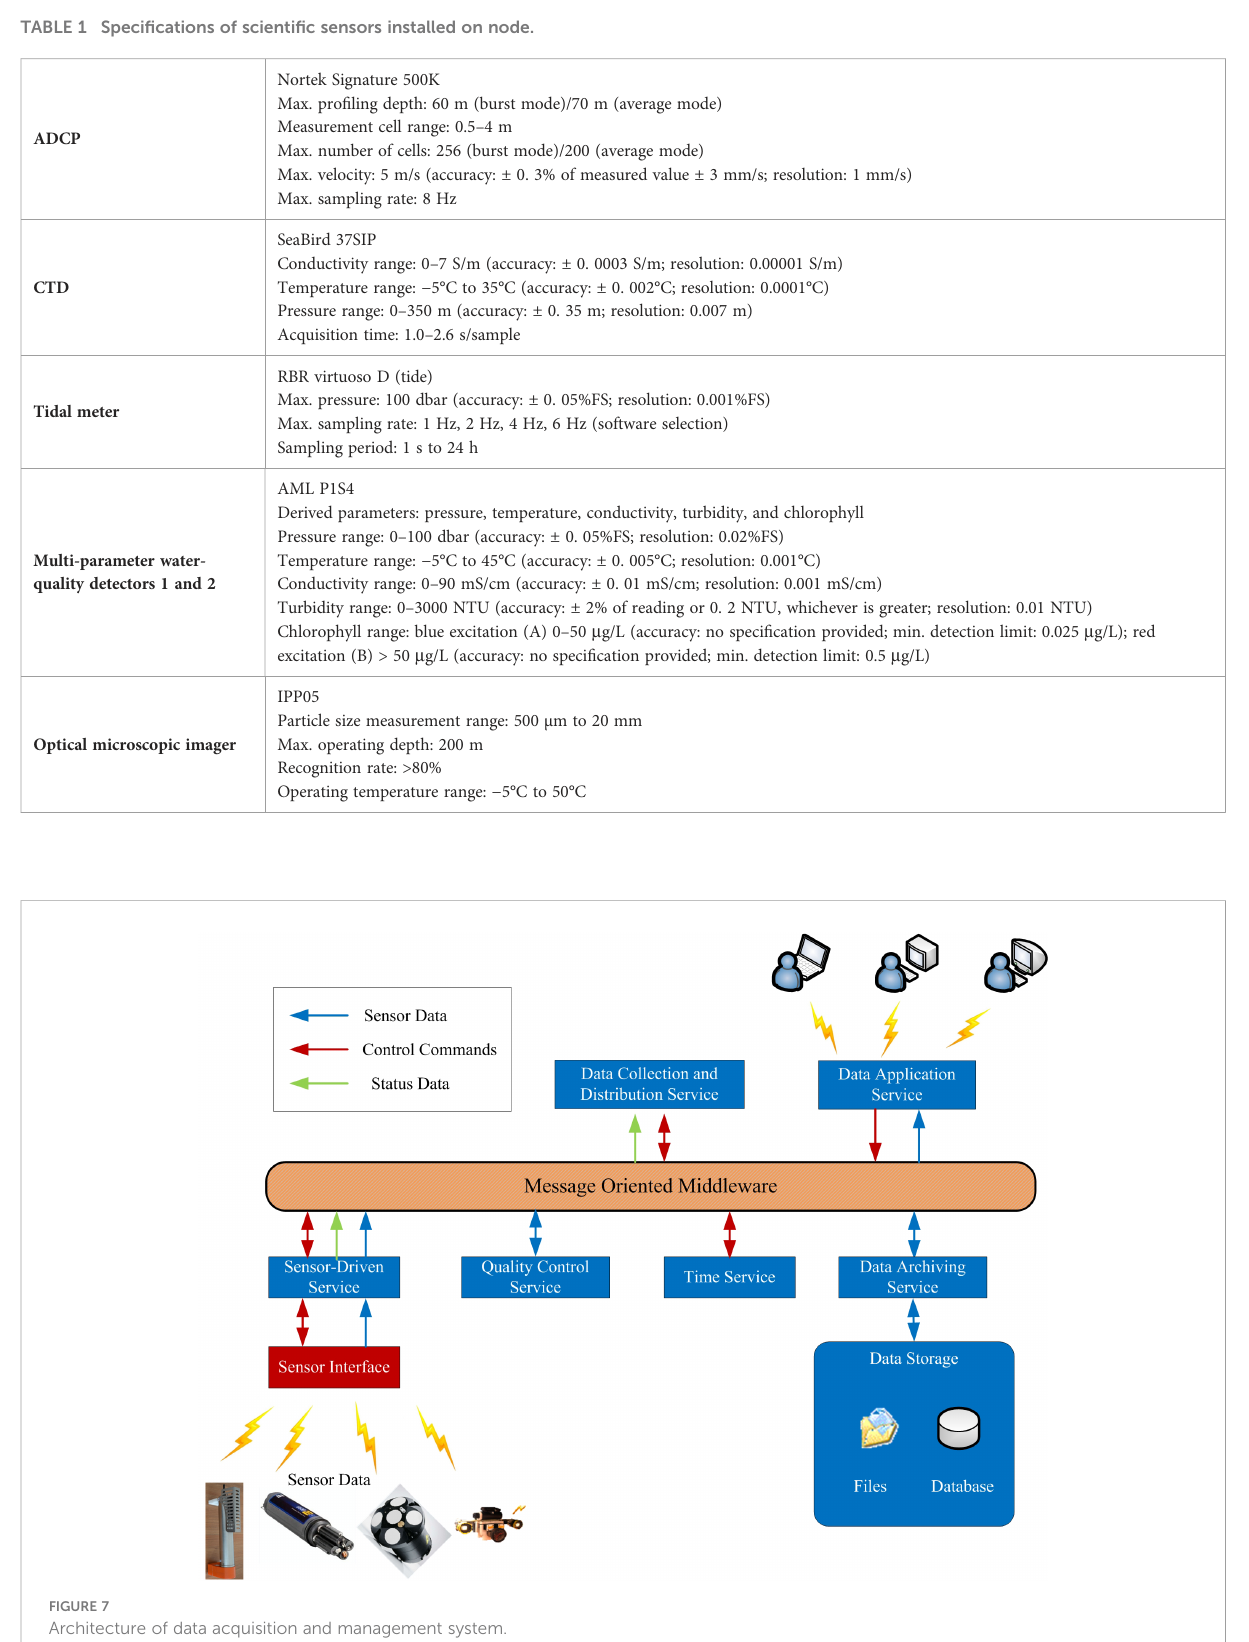
TABLE 1 Speci fi cations of scienti fi c sensors installed on node.